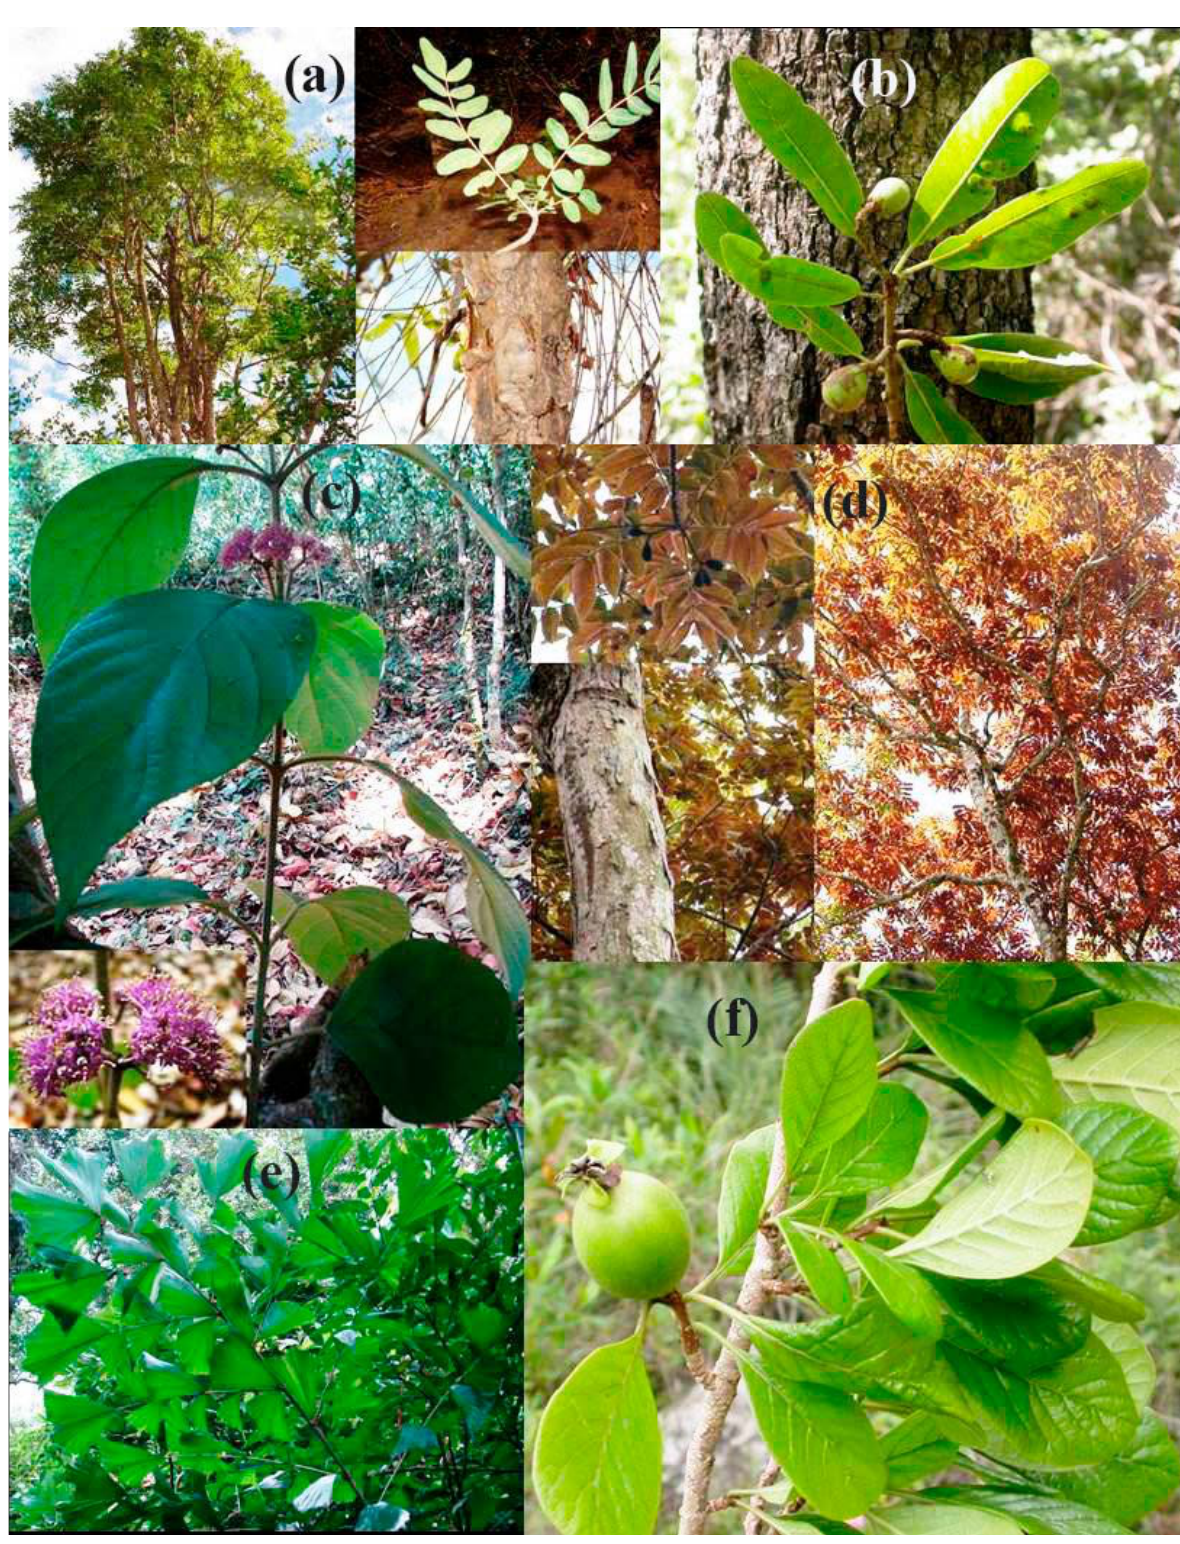
Figure 6. a) Boswellia serrata (Burseraceae); b) Buchanania axillaris (Anacardiaceae); c) Callicarpa tomentosa (Verbenaceae); d) Canarium strictum (Burseraceae); e) Caryota urens (Arecaceae); f) Catunaregam spinosa (Rubiaceae). Photo by L. Arul